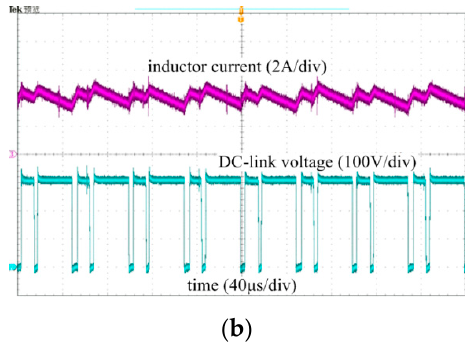
Figure 5. Steady state waveforms of ZSI ( a ) In load cycle; ( b ) In carrier cycle.